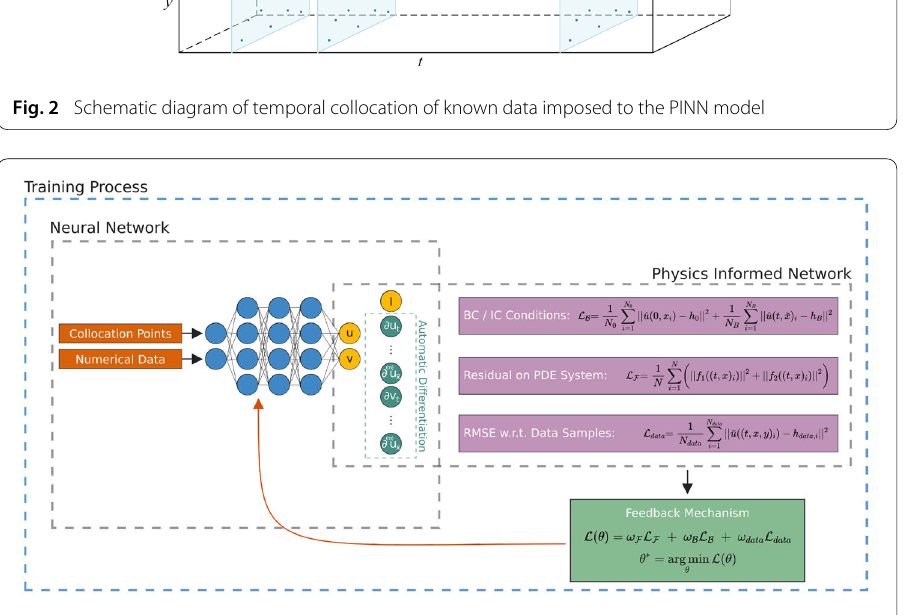
Fig. 3 General workflow of the proposed approach. Collocation points and samples from numerical simulations are used as inputs of the pipeline. The functions u and v are returned as output of the network. Automatic differentiation is used in order to compute the loss terms related to the dynamics. The training process calibrate the network’s parameters in such a way a surrogate model is obtained. It is worth noticing that Data related components are shown for the sake of completeness since they are only applied in the